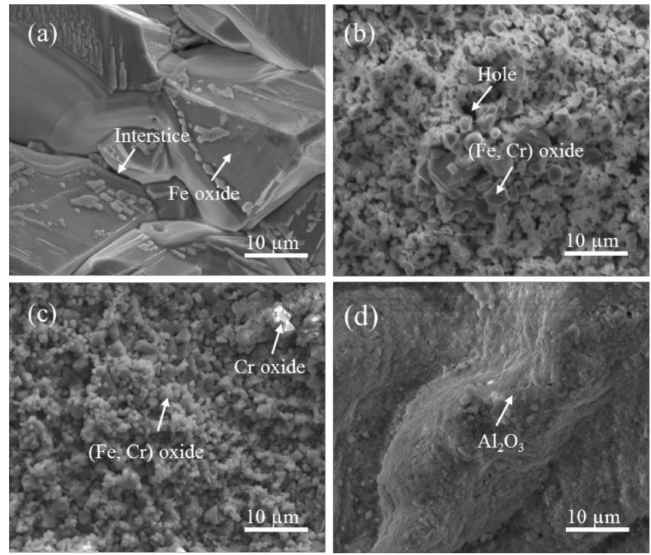
Figure 4. Surface morphology of the oxide scale on the steels with ( a ) 0, ( b ) 1.76, ( c ) 3.45, and ( d ) 5.34 wt% Al. The steels were oxidized at 1100 ◦ C for 480